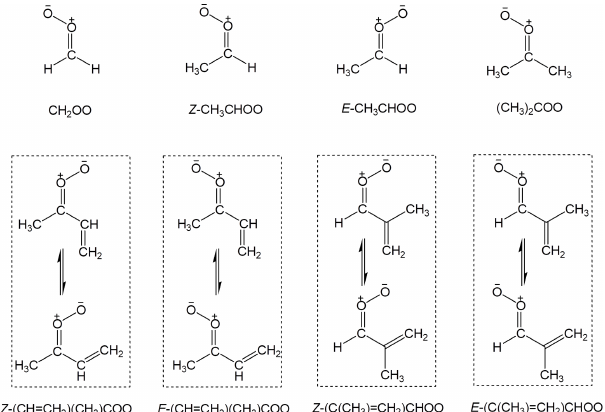
Figure 2. Structures of the stabilized Criegee intermediates consid- ered in the present evaluation, and the nomenclature assigned. In the cases of the di-substituted (isoprene-derived) C 4 intermediates, the Z and E notations specify the orientation of the first named sub- stituent (which has the higher Cahn–Ingold–Prelog priority) relative to the CI moiety. The displayed rotamers of the C 4 intermediates are calculated to be in near equilibrium under atmospheric conditions (Vereecken et al., 2017) and are assumed to act as a single species in each